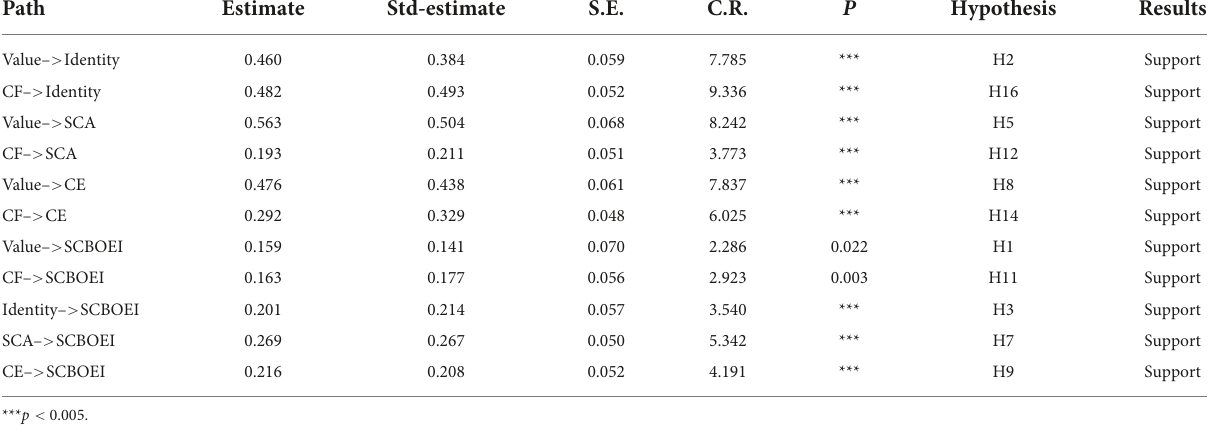
TABLE 10 Structural equation path test.